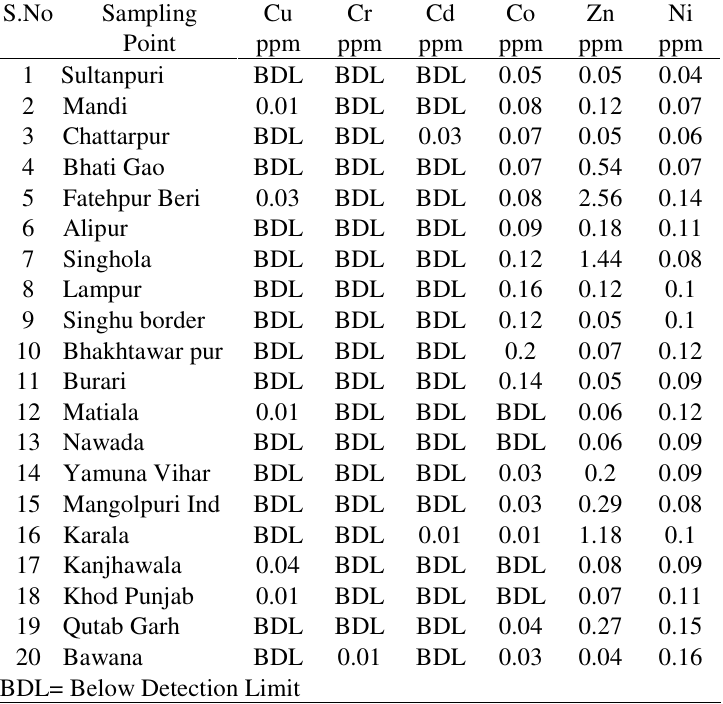
Figure 5. Sulphate content of various groundwater samples collected from Delhi. The concentration of heavy metals in water samples are given in Table 2. Cu concentration ranged from 0.04 to 0.01 ppm. Out of the trace metals, Zn is always in abundance in water with values ranging from 2.56 – 0.04 ppm. Table 2. Concentration of heavy metals in groundwater samples of